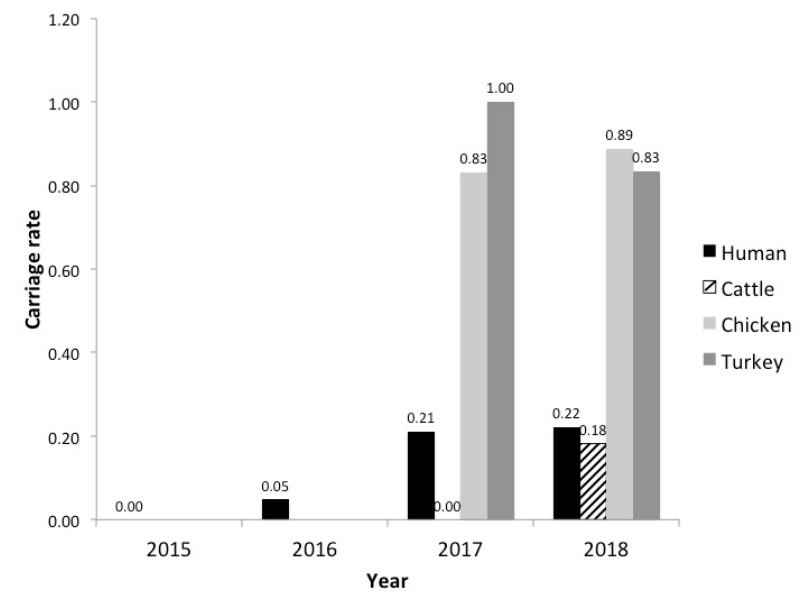
Figure 1. Carriage rate of the pESI plasmid in Salmonella Infantis chicken, turkey, and cattle isolates from USDA-FSIS and human isolates from CDC NARMS. 2015 and 2016 data was not analyzed for USDA-FSIS isolates. Total number of Infantis isolates for each year are as follows: n = 73 humans